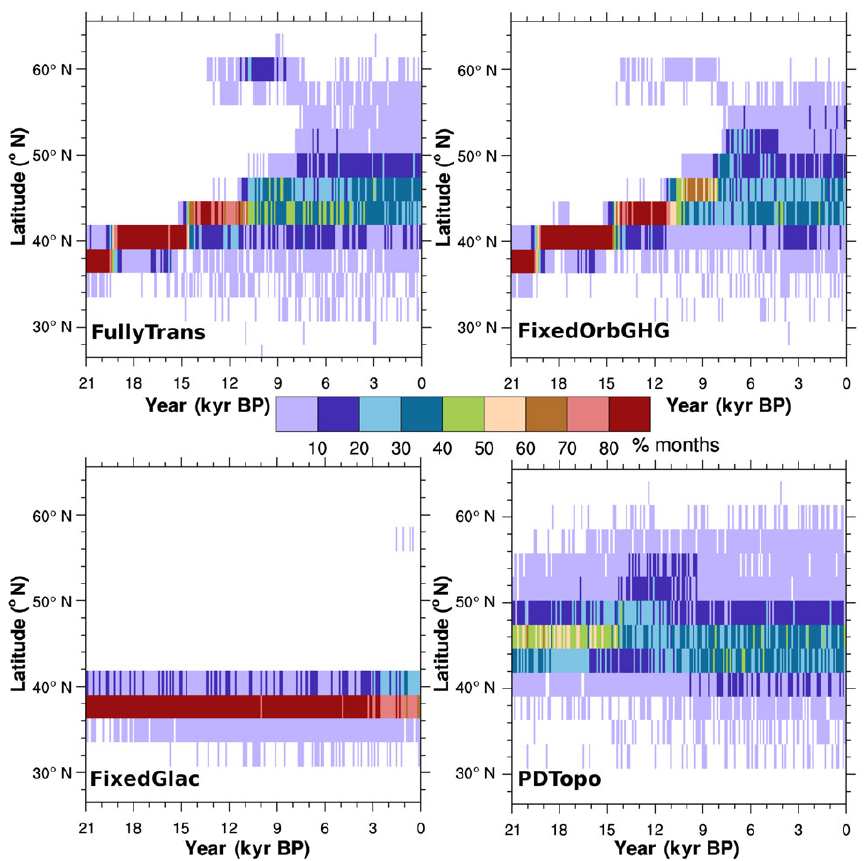
Figure 10. Frequency maps of NAtl western jet latitudes based on winds over 700 to 925hPa and 270 to 300 ◦ E in 10 successive winter seasons accumulated over all ensemble members of the FullyTrans, FixedOrbGHG, FixedGlac, and PDTopo experiments. Colours indicate the percentage of months with peak zonal winds within each latitude bin of width 2.8 ◦ at